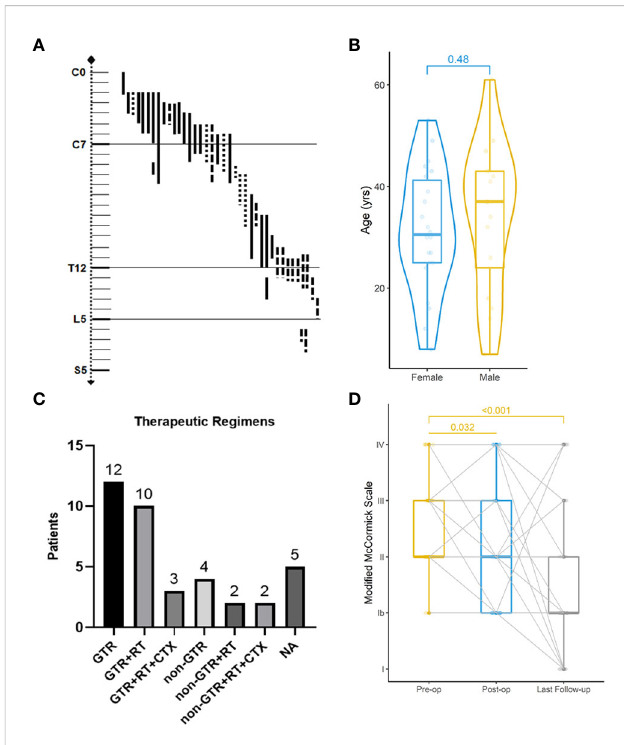
FIGURE 2 Clinical features, treatments, and neurological improvement of 38 patients from our institute. Localization of primary spinal anaplastic ependymomas (A) . ── , intramedullary; …… exophytic; − · − · intradural extramedullary . Age distribution of gender-based subgroups (Wilcoxon rank sum test) (B) . Various combinations of therapies (C) . GTR gross total resection; RT radiotherapy; CTX chemotherapy; NA not available. Preoperative (pre-op), postoperative (post-op) and the latest Modi fi ed McCormick classi fi cation of 38 patients (Friedman test) (D)